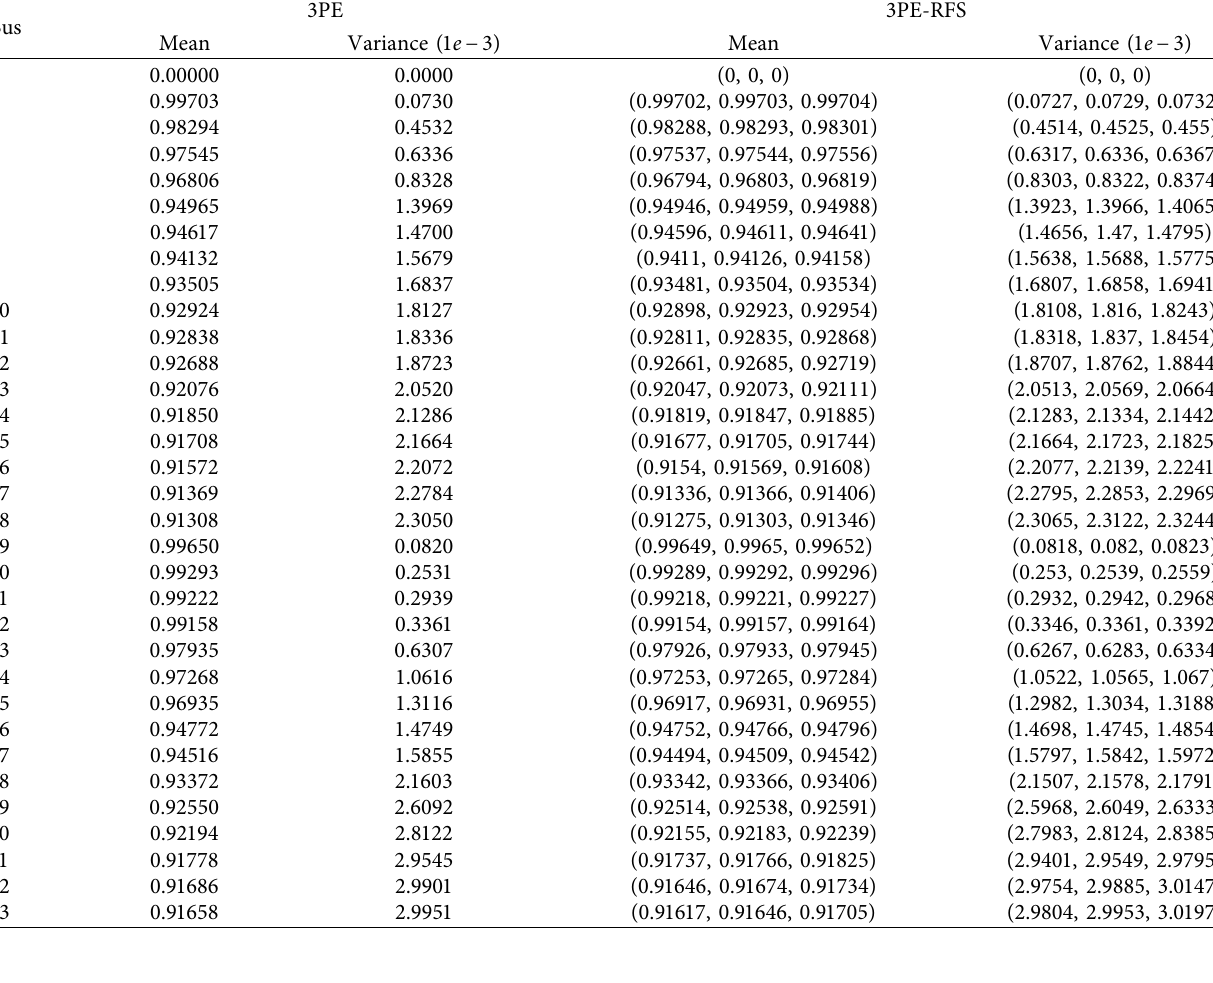
Table 1: Mean and variance of V